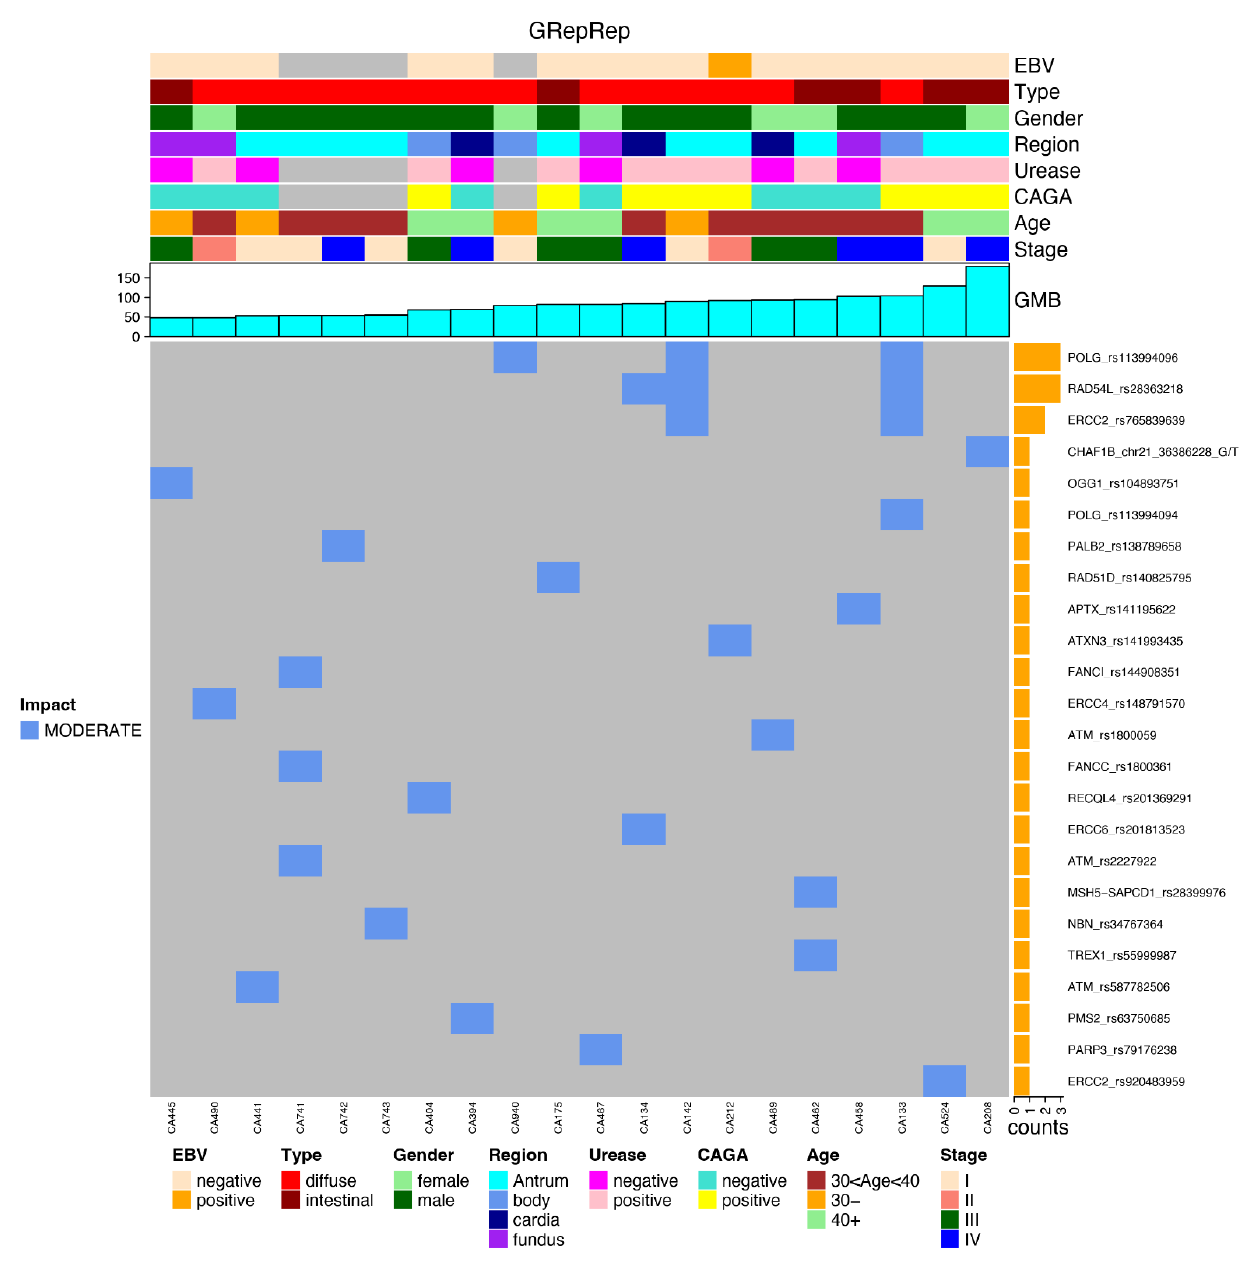
Figure 8. Correlation of most prevalent variants in the GRepRep gene’s subset among young patients with gastric cancer and their distribution according to clinical features (EBV status, histological type, gender, region of the stomach, urease status, CAGA status, age group and stage), GMB and mutation impact (moderate or high).